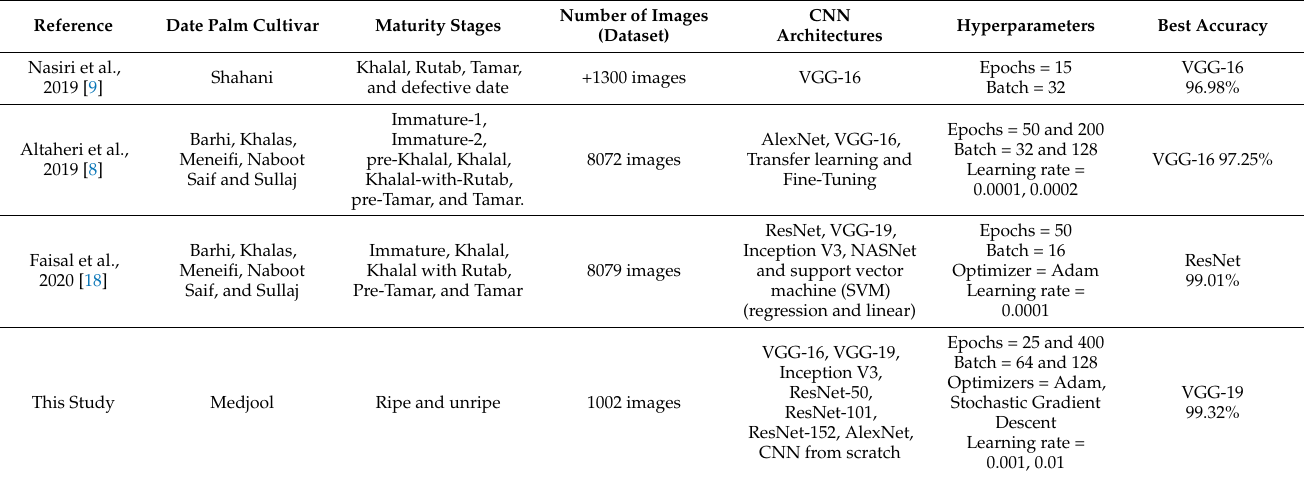
Table 4. Comparison of studies that report CNN architectures in the detection of various stages of maturity in the date palm fruit.